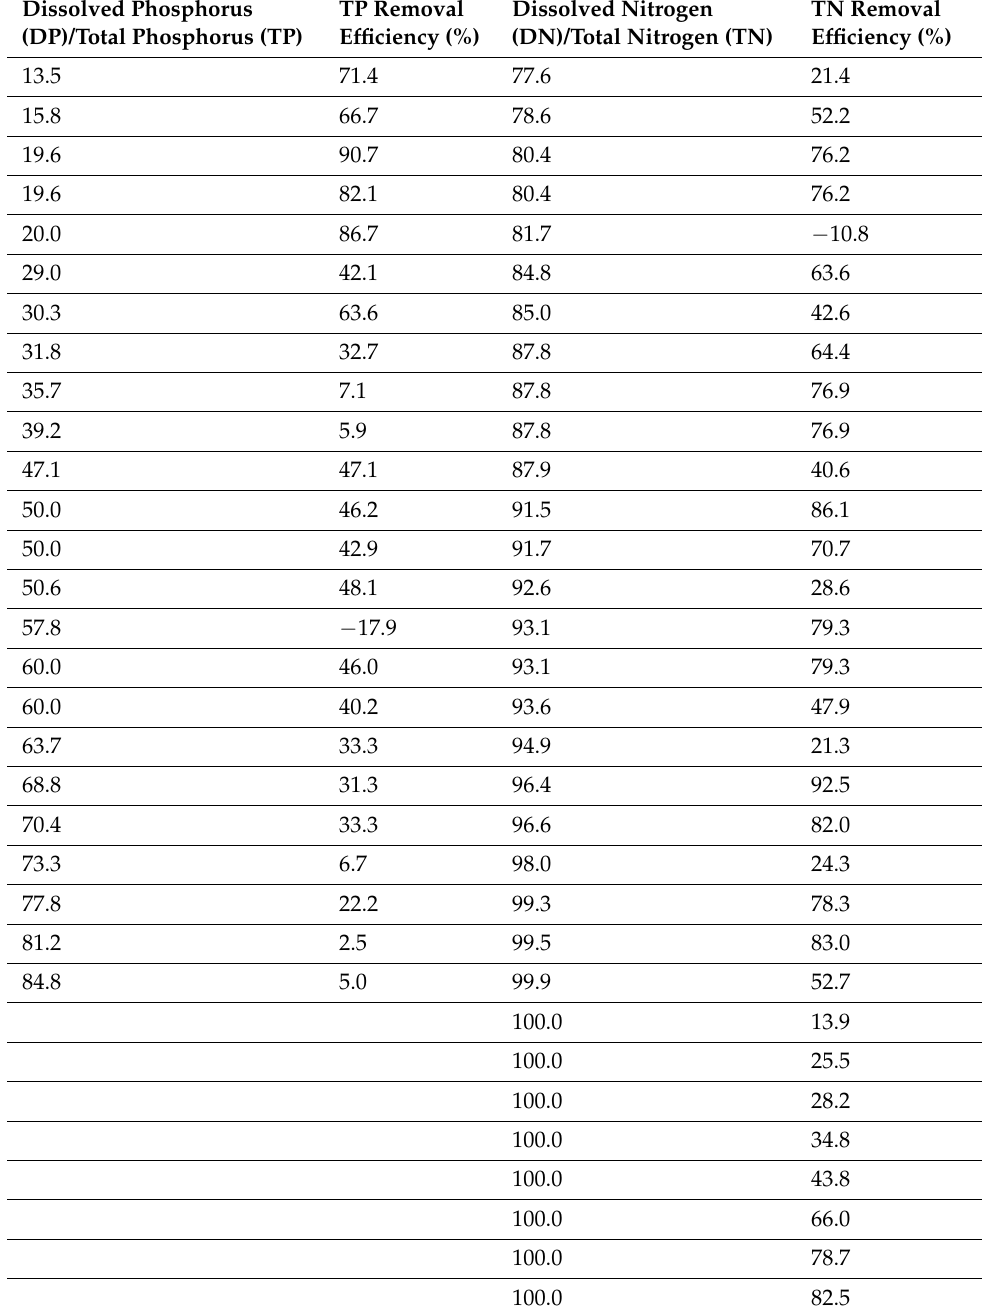
Table A10. Dissolved nutrient composition and respective removal